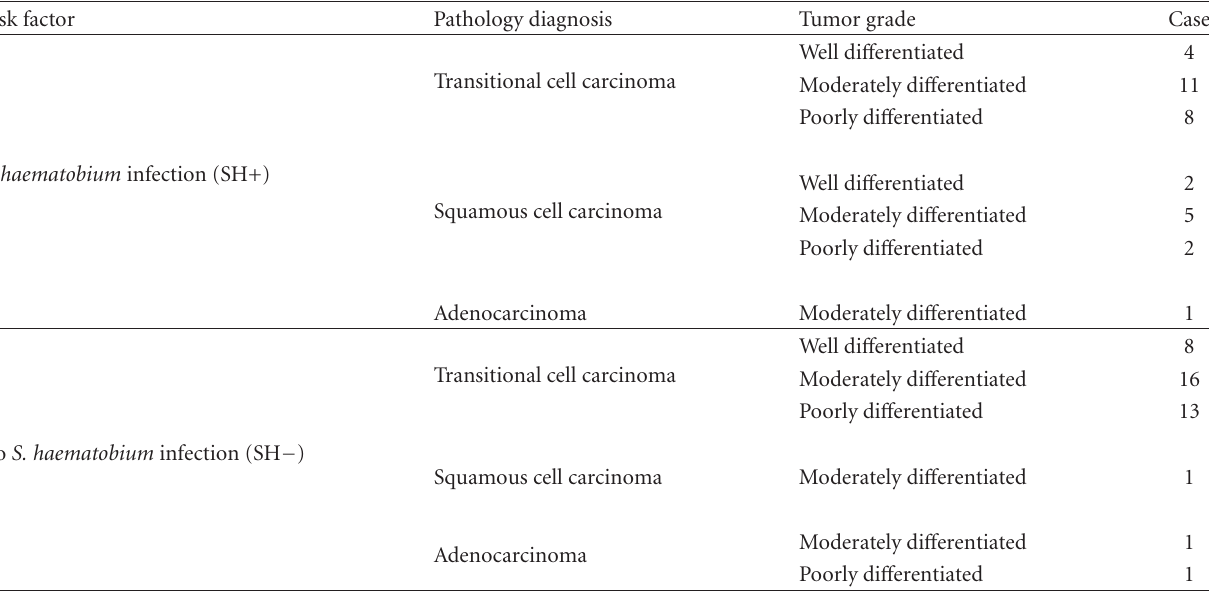
Table 1: Pathological analysis of urinary bladder tumor